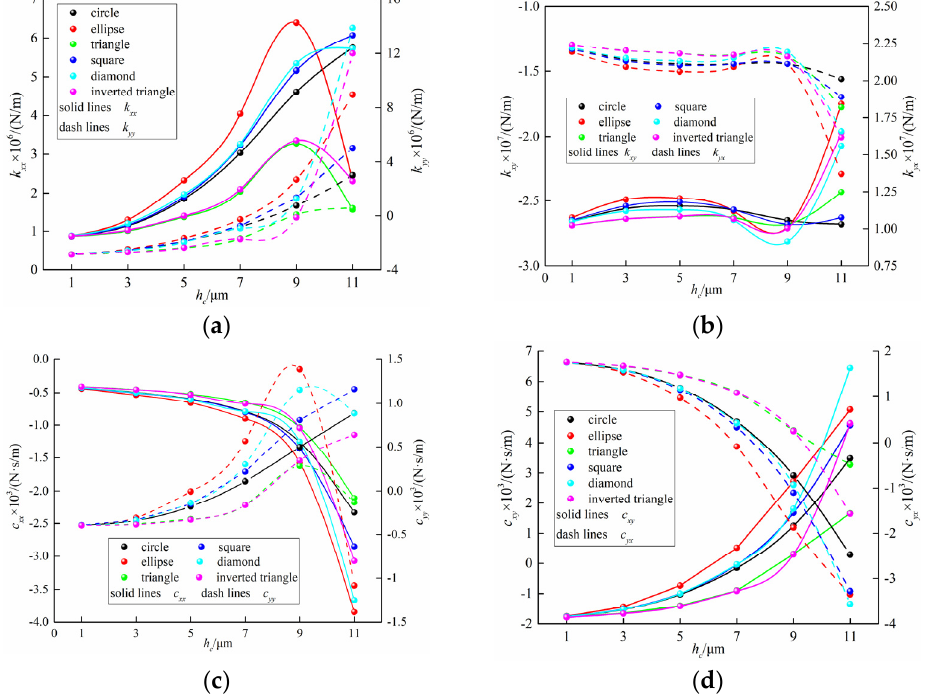
Figure 11. ( a ) Description of k xx and k yy with depth; ( b ) Description of k xy and k yx with depth. ( c ) Description of c xx and c yy with depth; ( d ) Description of c xy and c yx with depth.